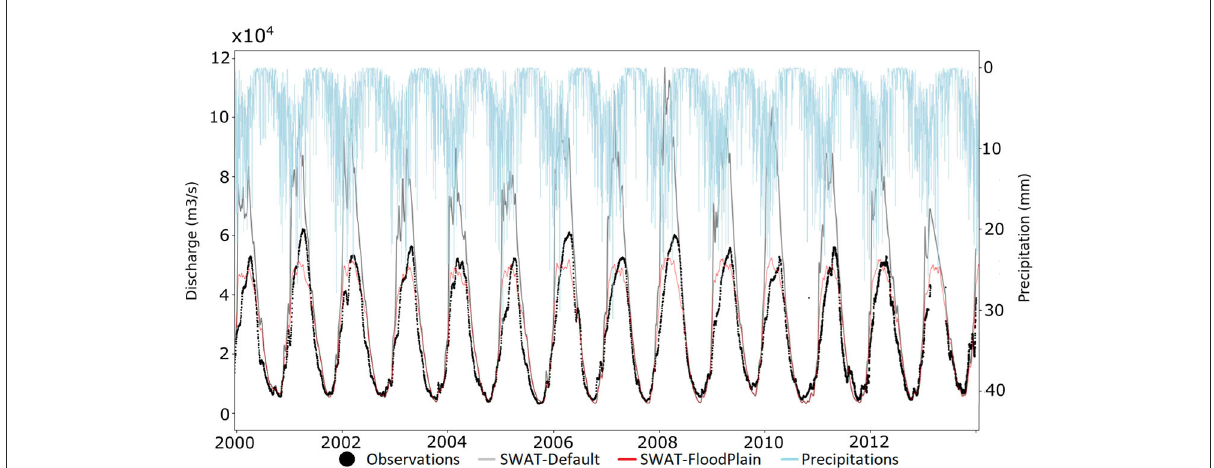
FIGURE4 Comparison of simulated discharges for the default SWAT version (gray line) and the SWAT-FloodPlain (red line) at the Fazenda gauging station ( 4.890; 60.026). The observations are displayed in black. The blue line represents the daily precipitations averaged over the whole watershed. − − For both simulations, parameters are run as follows: GW_DELAY 0.20, OV_N 0.10, and CANMX 200 and run with (Strauch and Volk, 2013), ESCO = = = Number (CN) were calibrated by